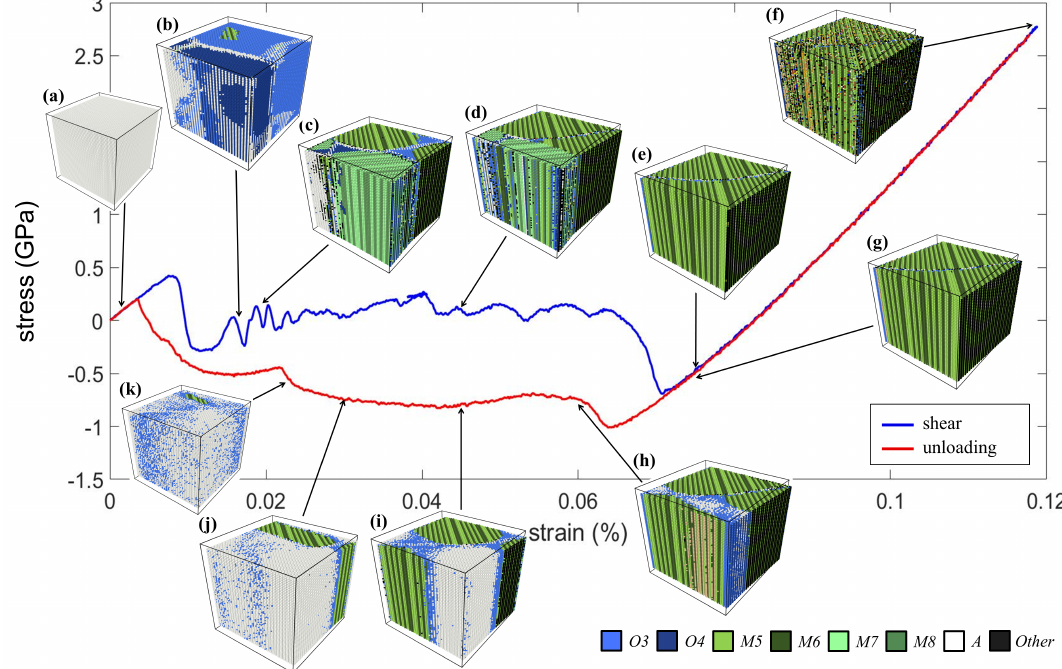
Figure 9. The stress-strain curve of the NiTi SMA subjected to the xy shearing load. The corresponding microstructures at Stages ( a – k ) are